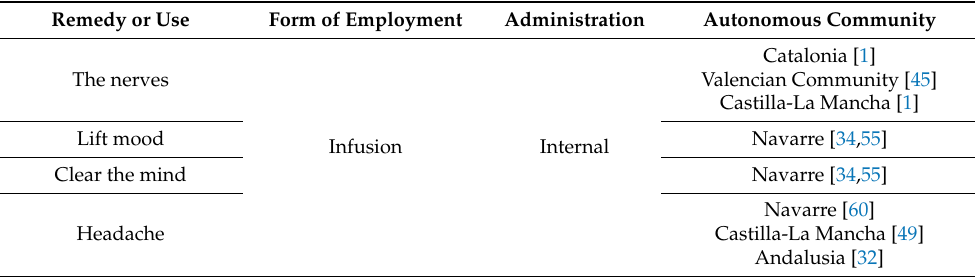
Table 5. Compilation of the medicinal uses of Chiliadenus glutinosus as a remedy for diseases of the nervous system in Spain, compiled from the existing specific